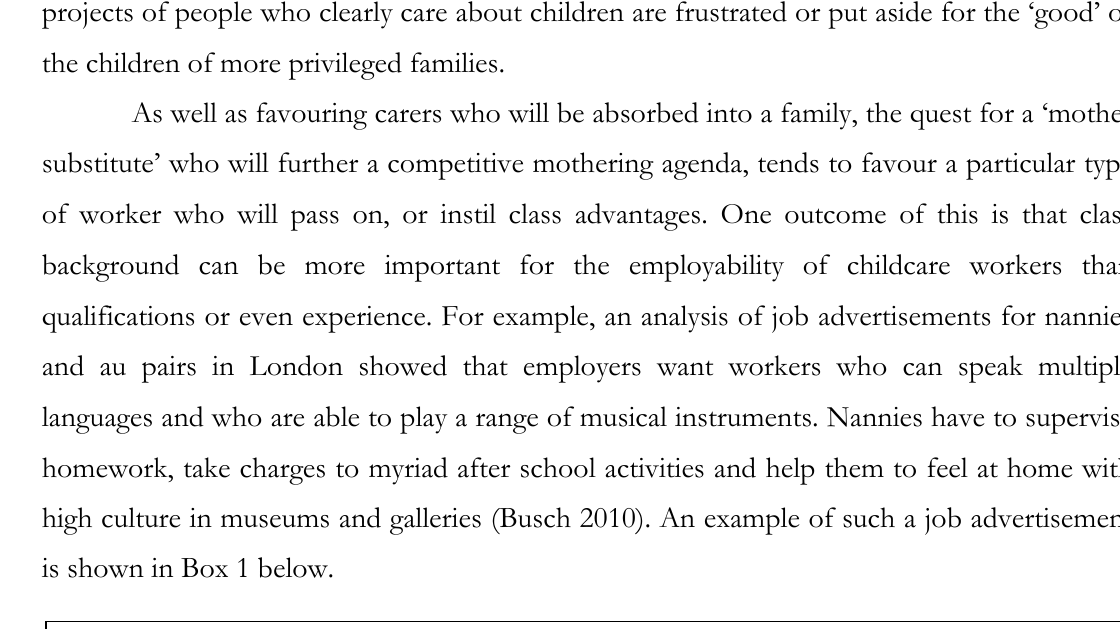
Rosie Cox: Competitive Mothering and Delegated Care: Class Relationships in Nanny and Au Pair